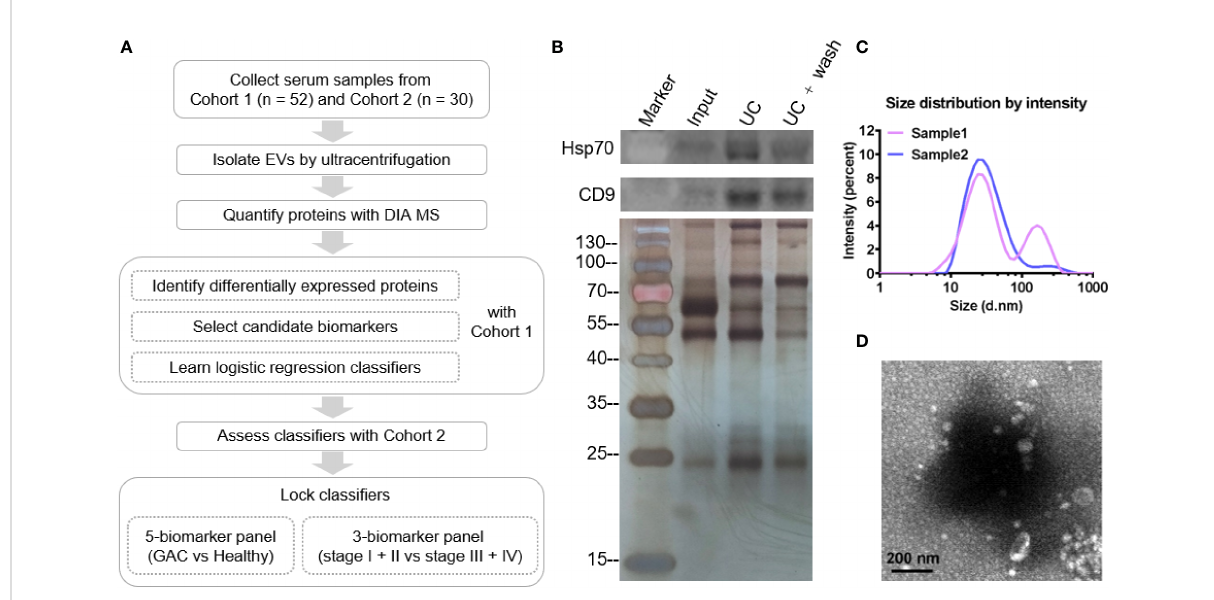
FIGURE 1 Design and quality assessment of isolated serum EV. (A) Flow chart displaying the study design of this study. (B) Western blot of EV samples showing Hsp70 and CD9, and SDS-PAGE of EV samples followed by silver stain. Input: serum; UC, ultracentrifugation. (C) Particle size distribution of isolated serum EV. (D) Representative TEM image of isolated EV. Scale bar: 200